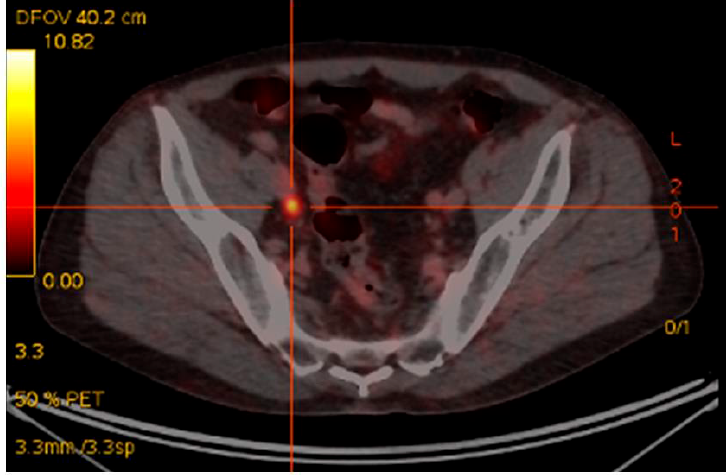
Figure 1. Rising PSA post-prostatectomy. PSA 0.9 ng/mL. CT unremarkable. 68 Ga-PSMA-avid right pelvic lymph node.